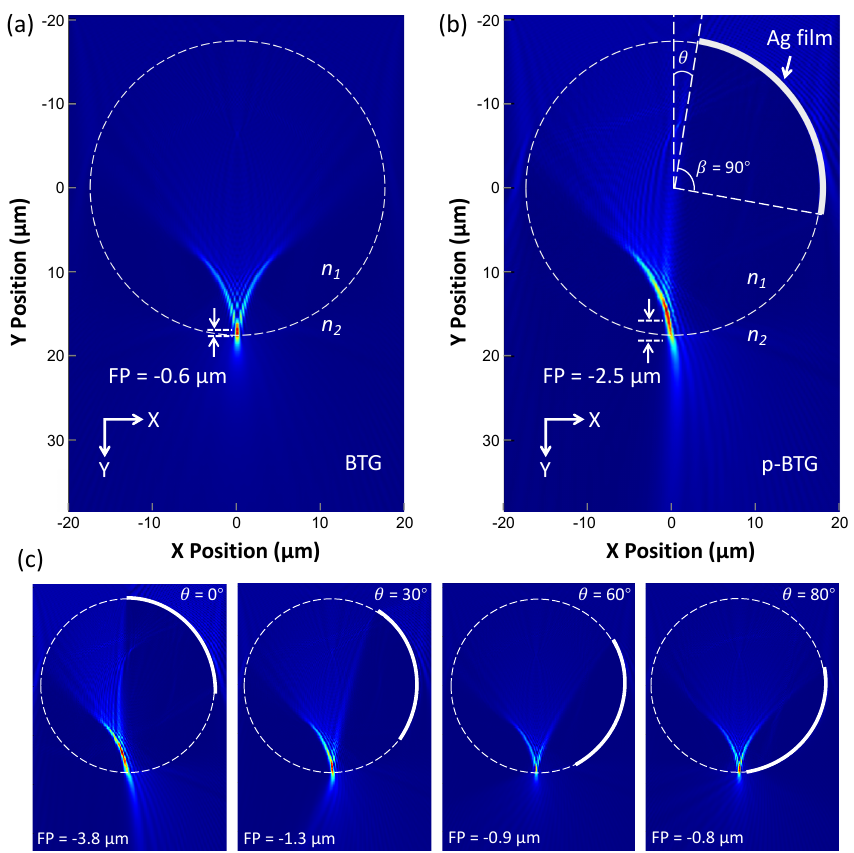
Figure 4. ( a , b ) FDTD-simulated light field of ( a ) the pristine BTG and ( b ) the p-BTG; ( c ) the influence of the position of Ag films on the focusing of the